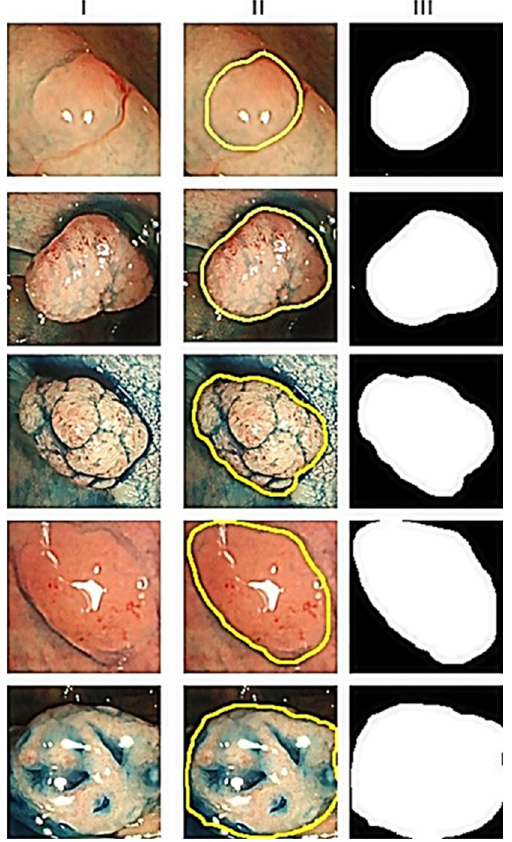
Figure 10. Generation of binary image for shape feature extraction. Column I, II, and III show the original image, ground truth image, and binary segmented image, respectively. All images displayed here are